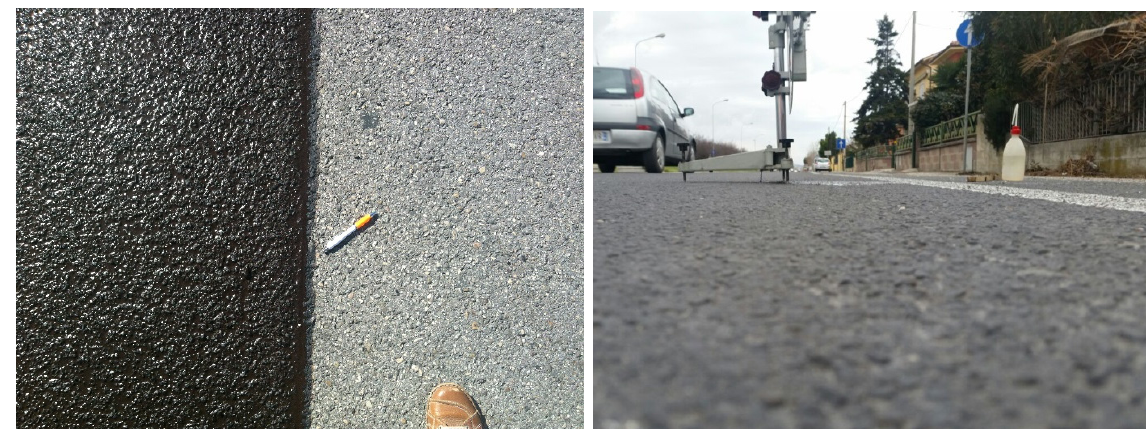
Figure 2. Example of an application of BSS in fresh state and after setting in Italy.